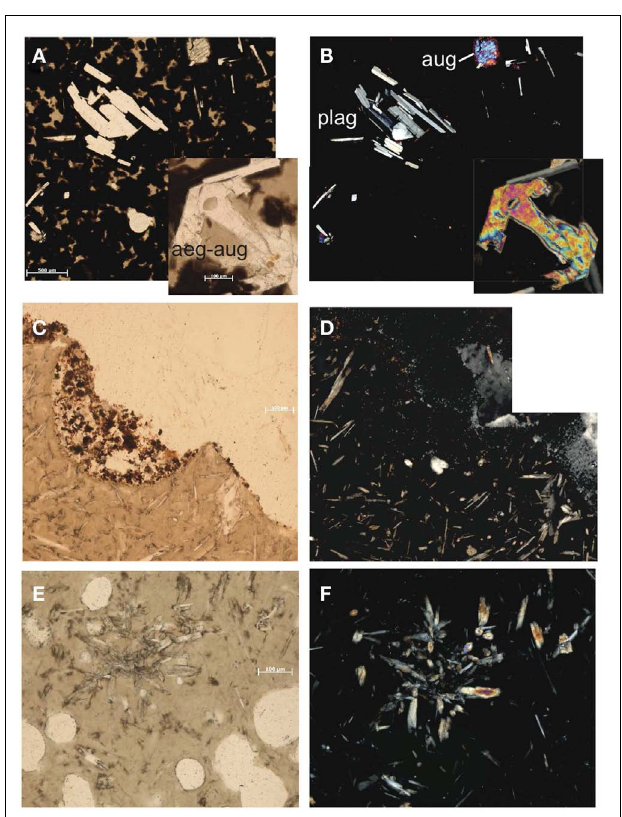
FIGURE 2 |Thin section photomicrographs of silicate samples. Plain polar light photomicrograph of basalt KiMba (A) and the same view in crossed polars (B) . Plain polar light photomicrograph of basalt ABEba (C) and crossed polars of the same view (D) . Plain polar light photomicrograph of sample basaltic andesite Marba (E) and crossed polar image of the same view (F)